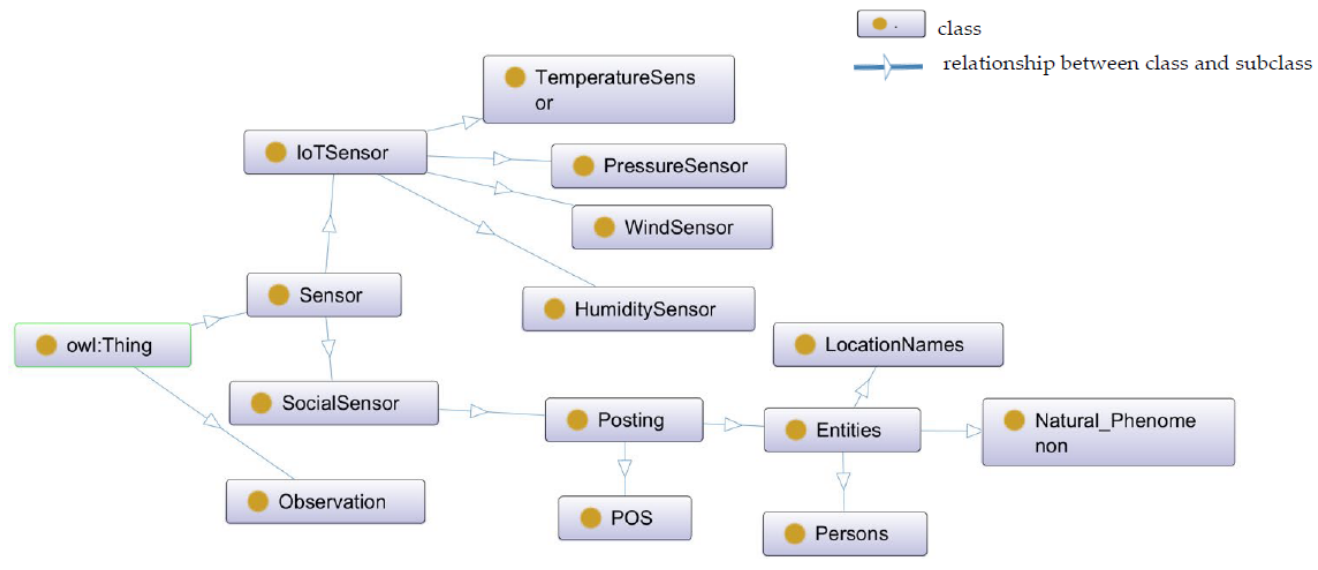
Figure 2. Top classes in semantic situation modelling. Table 2. Ontologies that can be used to model situations in the proposed situation model when using combined information spaces.